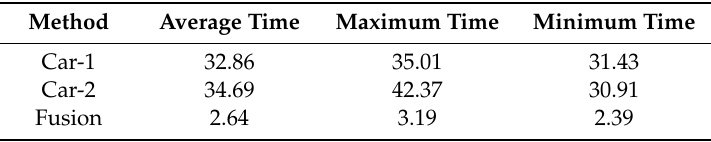
Table 3. Execution time (ms) for MOT.